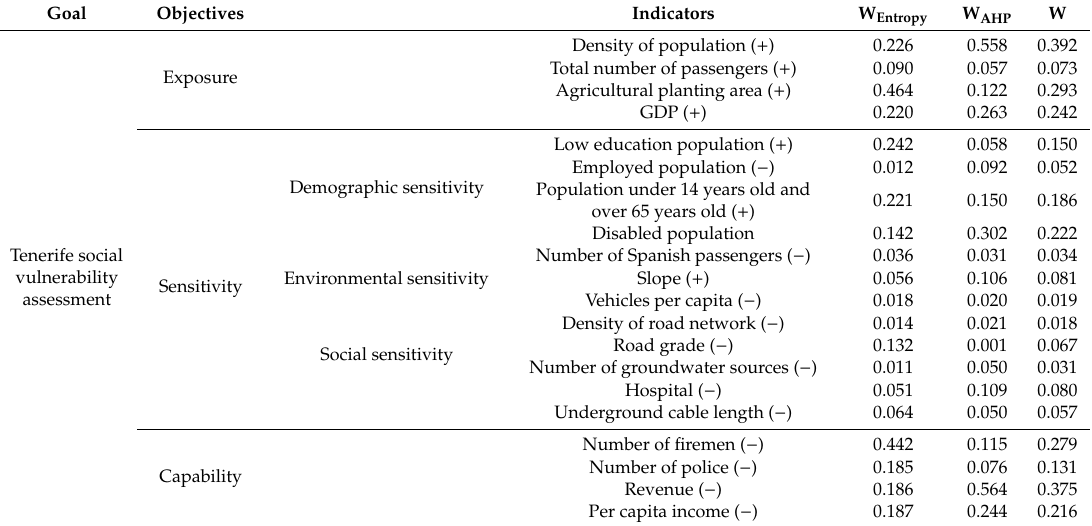
Table 6. Weight of each Tenerife social vulnerability assessment indicator (where W Entropy denotes the entropy-based weight, W AHP denotes the AHP-based weight, and W denotes the overall weight). While a positive symbol indicates that these indicators increase vulnerability, a minus symbol implies a negative e ff ect on